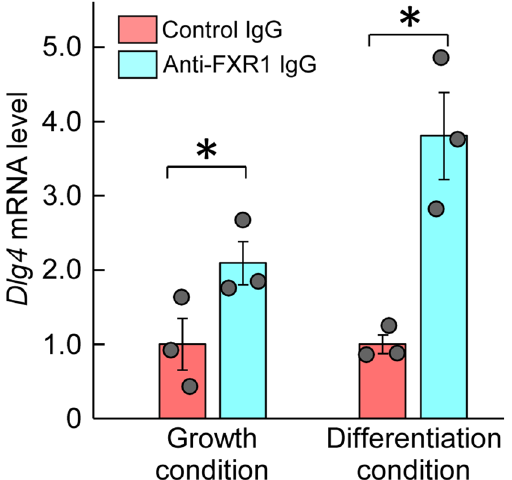
Figure 3. Association between FXR1 protein and Dlg4 mRNA. Immunoprecipitation with anti-FXR1 antibody was performed in def.FMRP-N2a cells (in the absence of FMRP) cultured under normal growth and retinoic acid (RA)-added differentiation conditions. RNA was extracted from the precipitants with anti-FXR1 IgG or control IgG and examined by qRT-PCR for Dlg4 . The data were normalized by the data of control IgG as 1. Data are shown as mean ± SEM ( n = 3 independent determination, * P < 0.05 by one-tailed t-test).